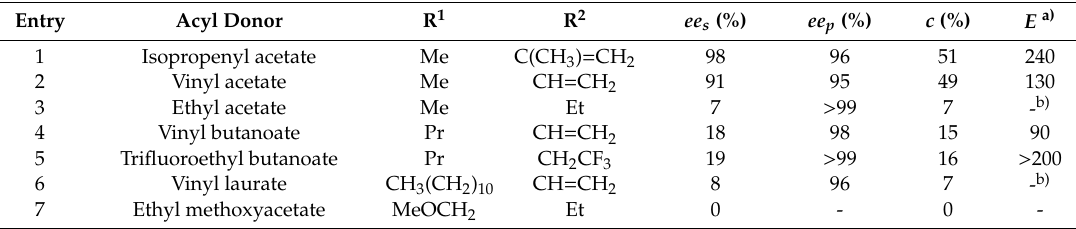
Table 1. CAL-A-catalyzed (NZL-101-IMB; 60 mg / mL) O -acylation of rac - 1 (5.0 mM) with various acyl donors (150 mM) ( t = 96